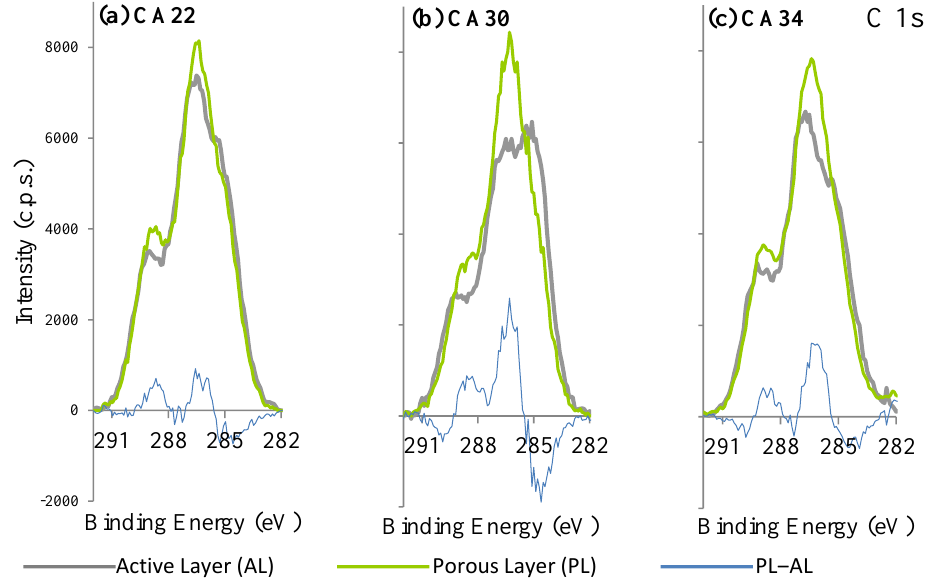
Figure 4. XPS C 1s regions of active layers (AL) and porous layers (PL) of CA membranes. ( a ) CA22, ( b ) CA30, and ( c ) CA34. The blue line is the difference between the PL and AL spectra. Little difference between AL and PL was observed for the silver-free CA22 membrane and for the CA22 silver-containing membranes (CA22Ag0.1 and CA22Ag0.4,